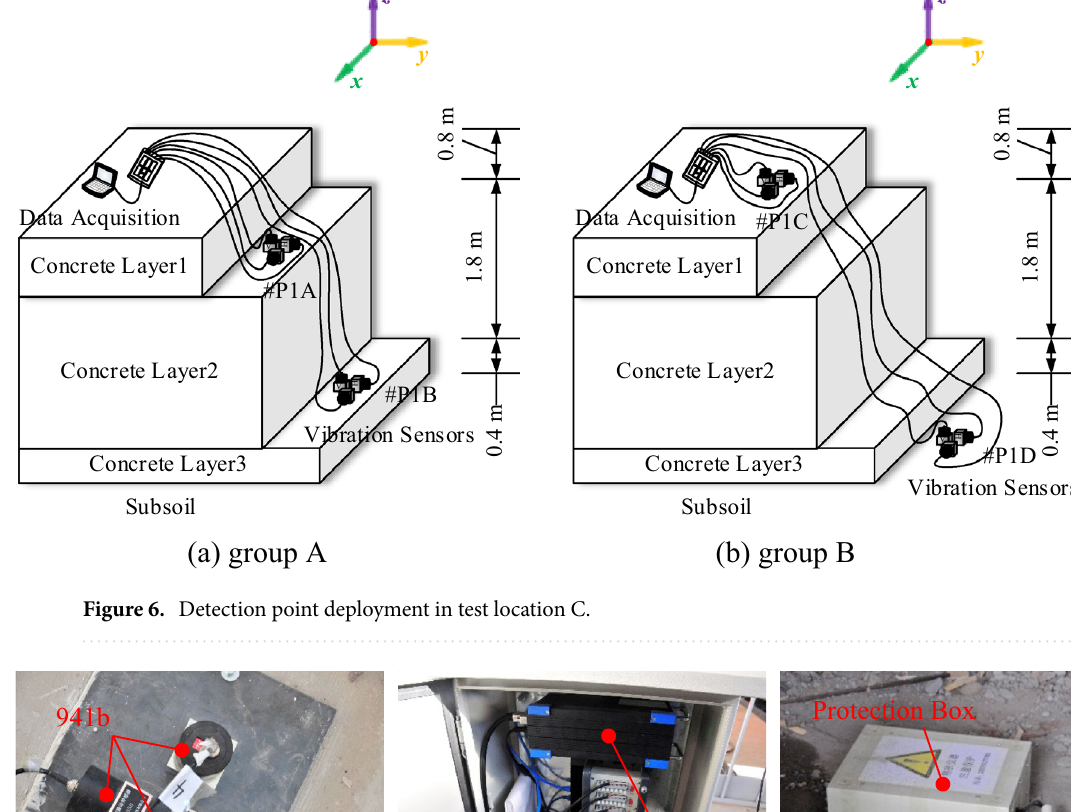
Figure 6. Detection point deployment in test location C.